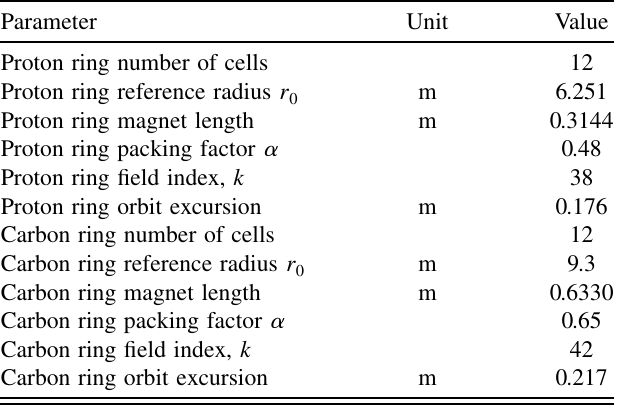
FIG. 4. Beta functions in one cell of proton lattice.